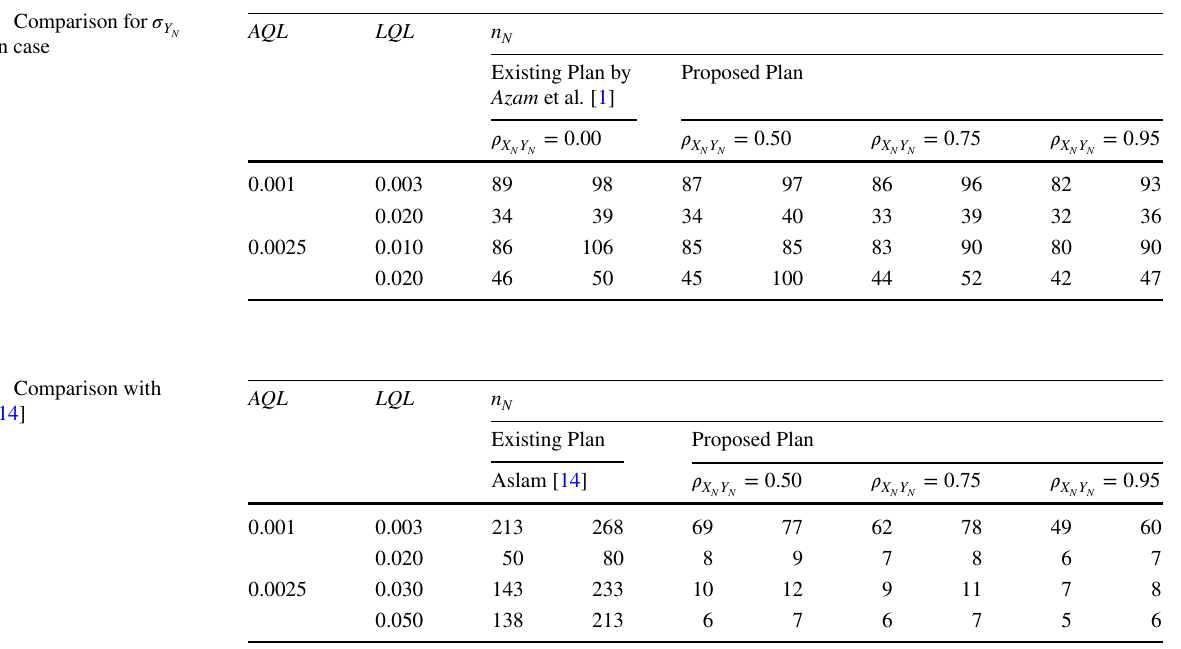
Table 10 Comparison for 𝜎 Y unknown case